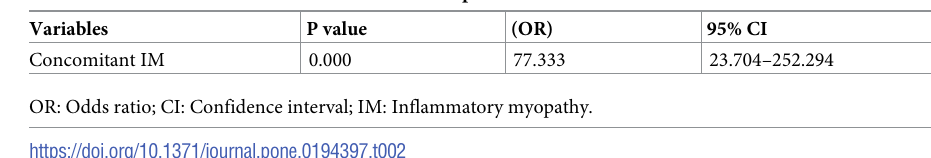
Table 2. Risk factors of cardiac involvement in PBC